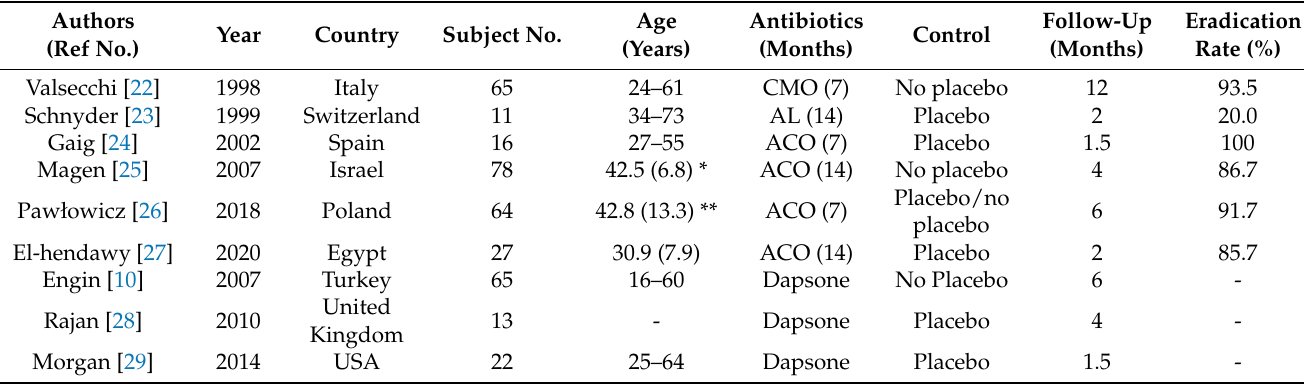
Table 1. Summary of the characteristics of the eligible studies.